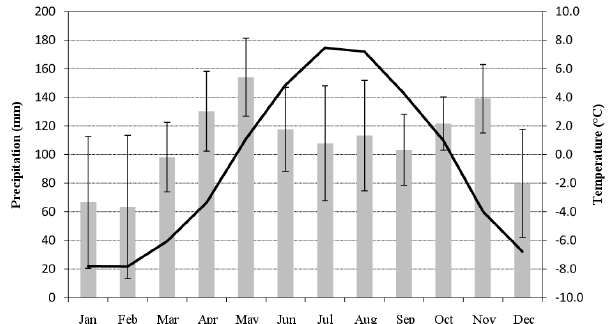
Fig. 2. Monthly air temperature (line) and precipitation (histogram) at the Careser dam weather station (2605 m a.s.l.), averaged over the period 1959-2009. Bars on histogram indicate one standard deviation.